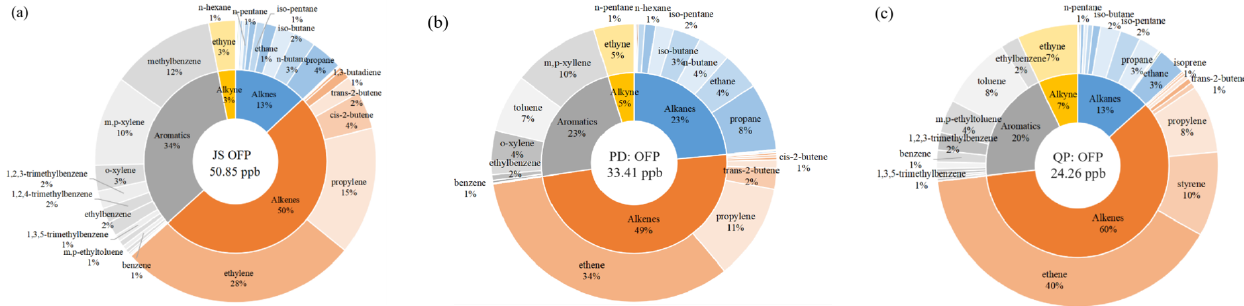
Figure 8. Contributions of VOCs to OFP at the (a) JS, (b) PD and (c) QP sites (the contributions > 1% were marked).